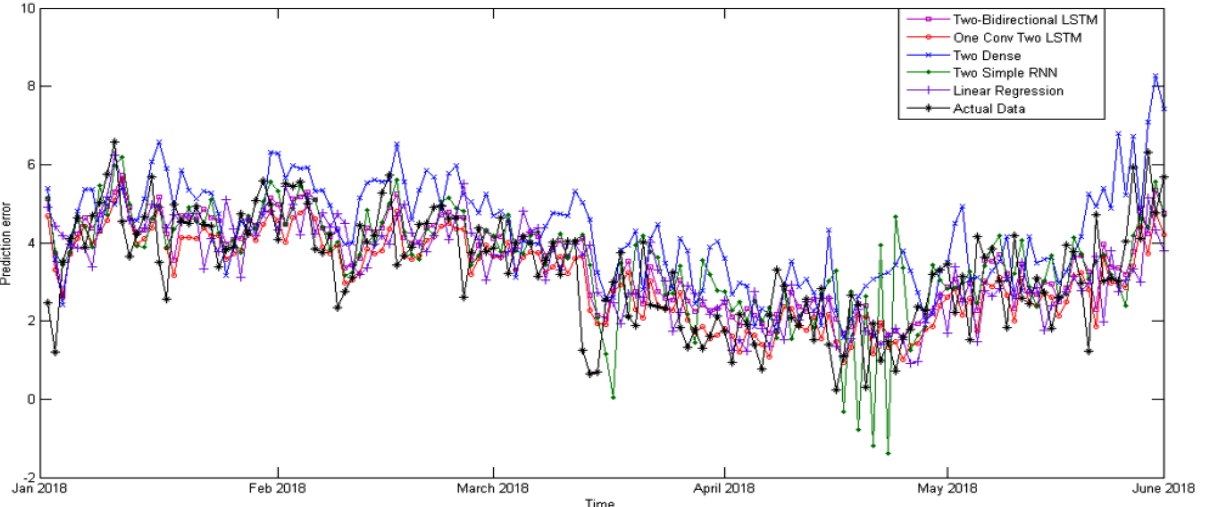
Figure 4. Prediction plot of wind speed data of considered model in Coimbatore dataset from Jan 2018 to June 2018.